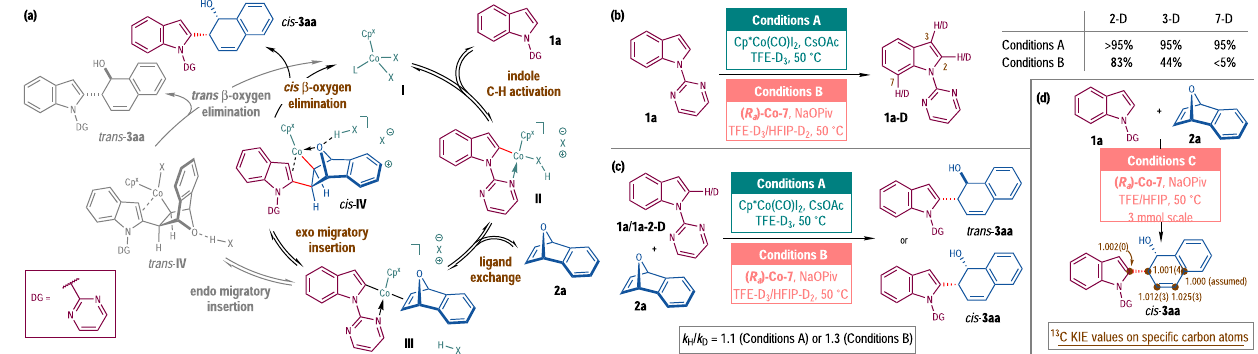
Fig.4|Proposedcatalyticcycleanddeuterium-labelingandkineticisotopeeffectexperiments.a Proposedcatalyticcycle. b Deuterium-labelingreactionsof 1a . c H/D Kinetic isotope effect (KIE) experiments. ( d ) 12 C/ 13 C KIE